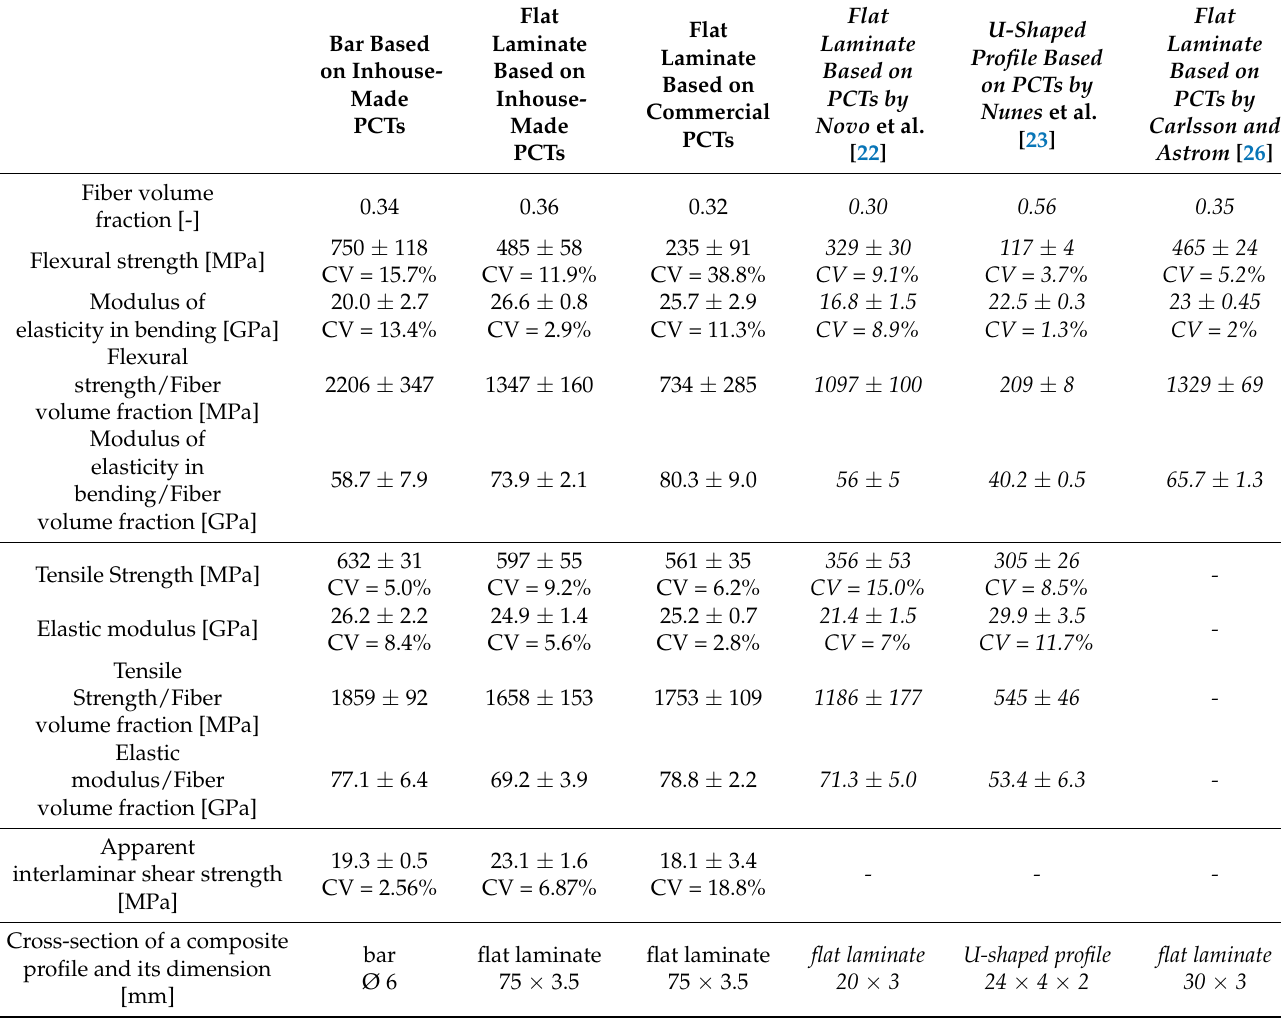
Table 2. Mechanical properties of pultruded thermoplastic